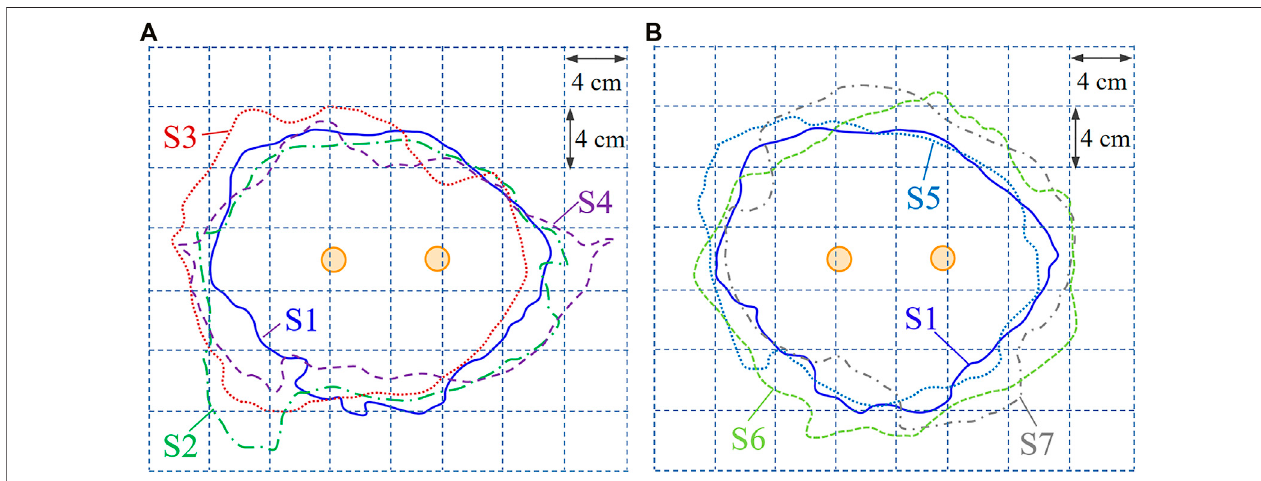
FIGURE9|(A) CratersurfaceoutlineofS1,S2,S3,andS4. (B) CratersurfaceoutlineofS1,S5,S6,andS7.Comparisonofcratercontourunderdifferentpressure directions.